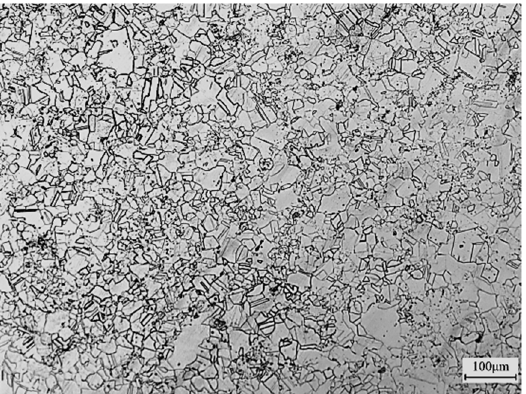
Figure 1. Original metallographic structure of GH901 superalloy.